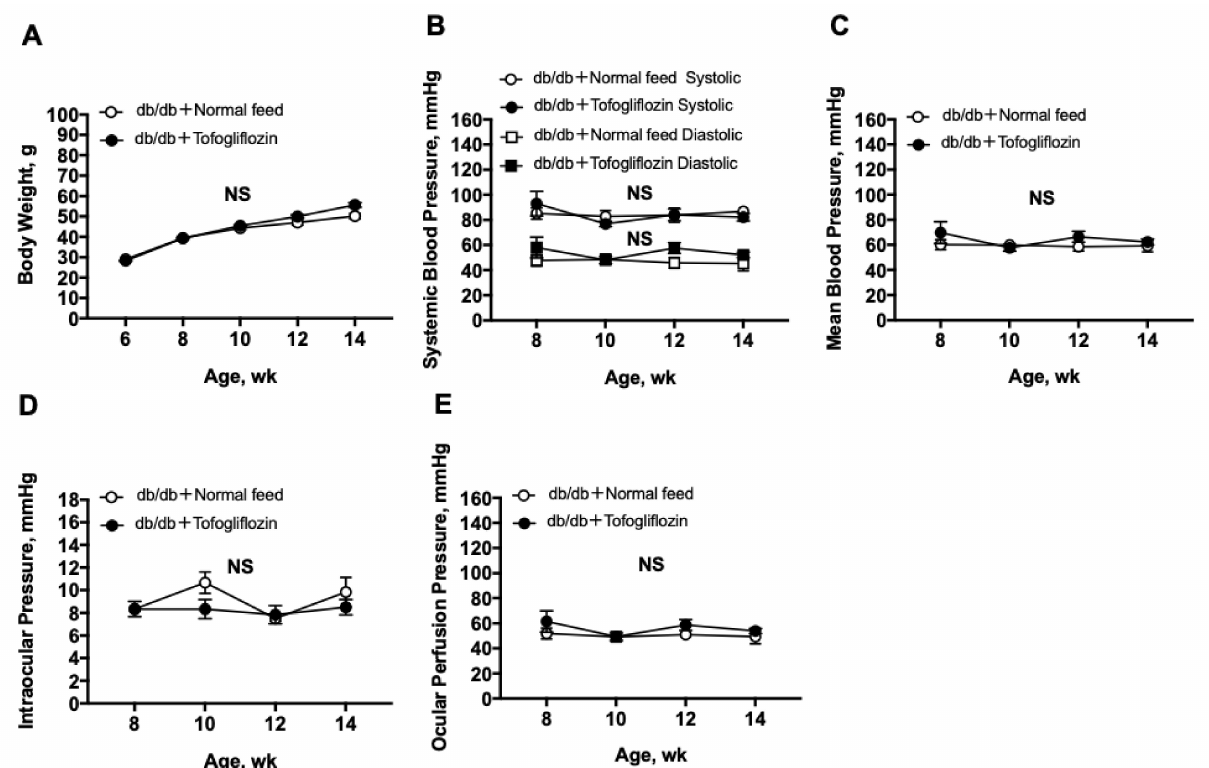
Figure 1. Tofogliflozin did not change the level of other systemic or ocular parameters: ( A ) body weight; ( B ) systemic BP; ( C ) mean BP; ( D ) IOP; ( E ) OPP. Body weight was measured every 2 weeks from 8 weeks to 14 weeks of age. Systemic BP, mean BP, IOP, and OPP were measured every 2 weeks from 8 weeks to 14 weeks of age. Each parameter was compared between tofogliflozin-treated db/db mice (db/db + tofogliflozin) ( n = 6) in db/db mice fed normal chow (db/db + normal feed) ( n = 6) by two-way repeated-measures analysis of variance (ANOVA). Data are expressed as the mean ± SEM. NS indicates no significant difference between groups.